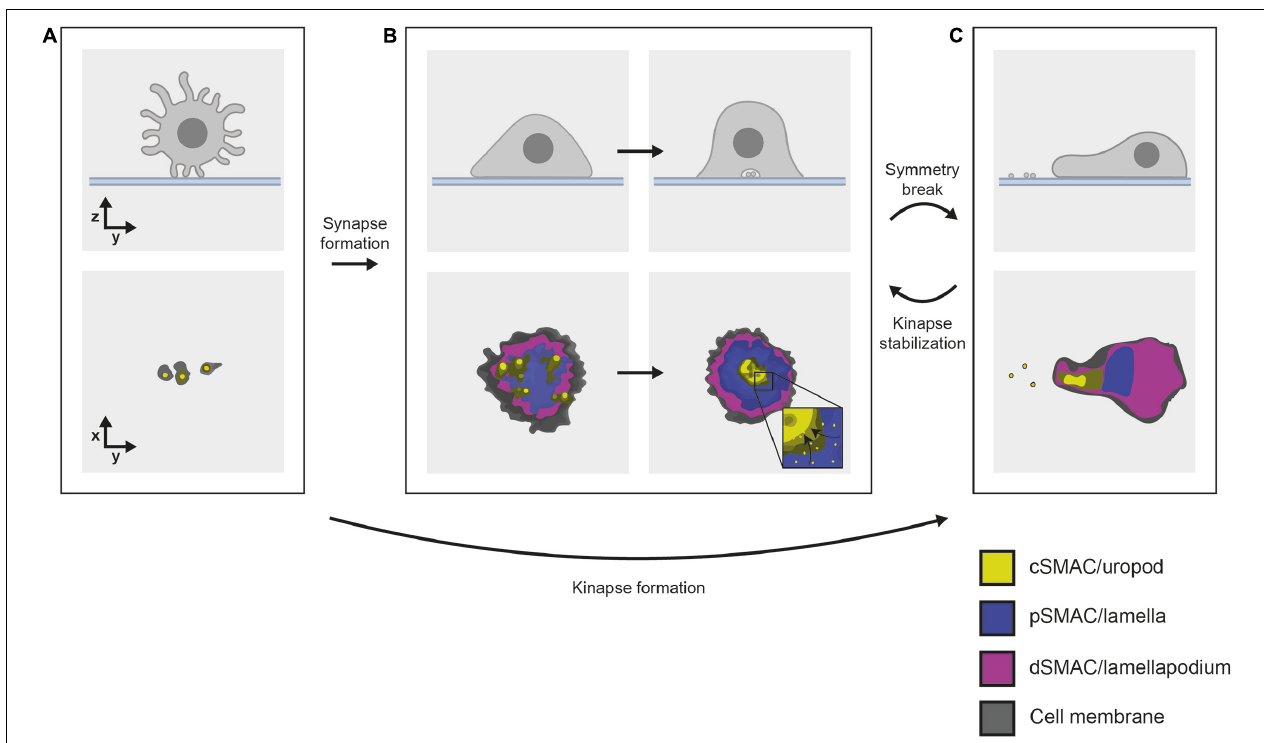
FIGURE 1 | (A) T cells interact with functionalized lipid bilayers using multiple microvilli, forming either (B) a radially symmetric immunological synapse or (C) an asymmetrical, motile kinapse. These structures consist of organized SMAC domains which correspond to the underlying actin networks, indicated by color. Effector vesicles/particles are indicated by small membrane-bound circles. The kinapse is the primary behavior adopted by most human T cells stimulated by antigen with the exception of CD8 + memory T cells which are more likely to form stable